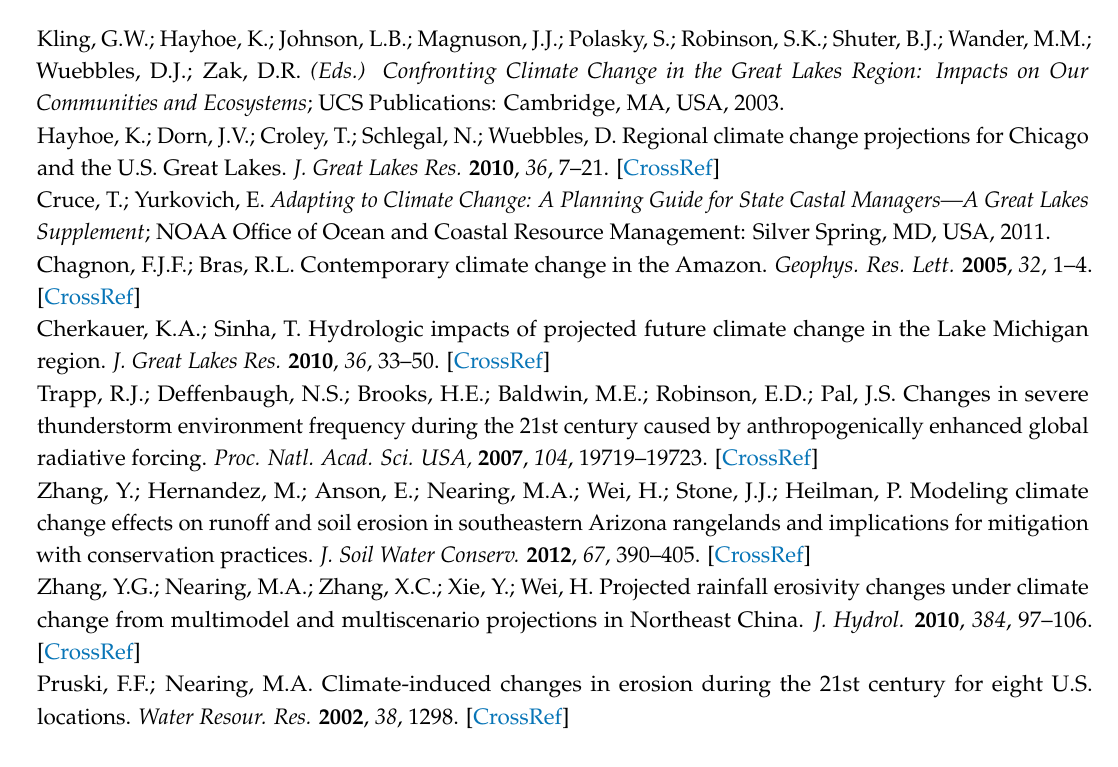
Figure S1: Predicted average annual precipitation, air temperature, runoff, and soil loss results (base value, and differences between early century, middle century, and late century periods and base period) under the A2 scenario for the Great Lakes region., Figure S21: Predicted seasonal soil loss results under the A2 scenario for the Great Lakes